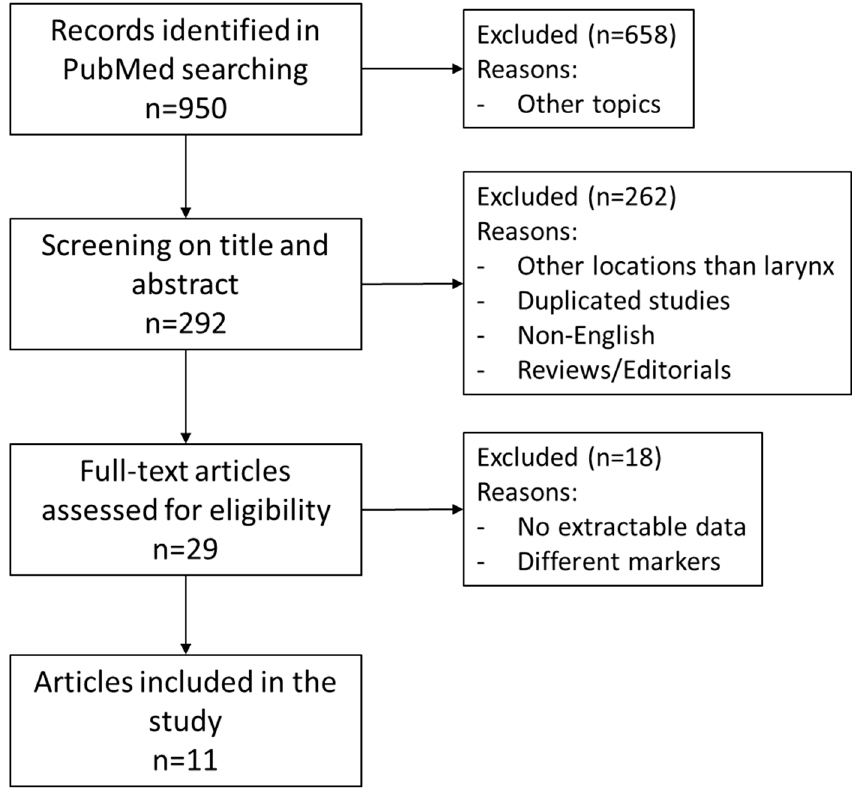
Figure 1. Flow chart showing the process of the study selections for the systematic review.